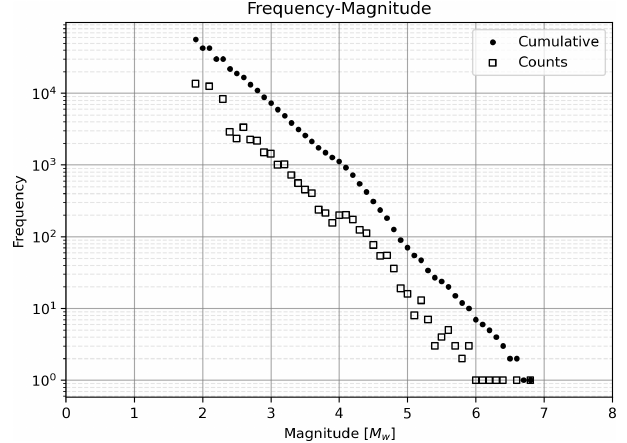
Figure 2. Frequency-magnitude plot for the Italian CPTI15 earth- quake catalog. This catalog contains a total of 56309 events.